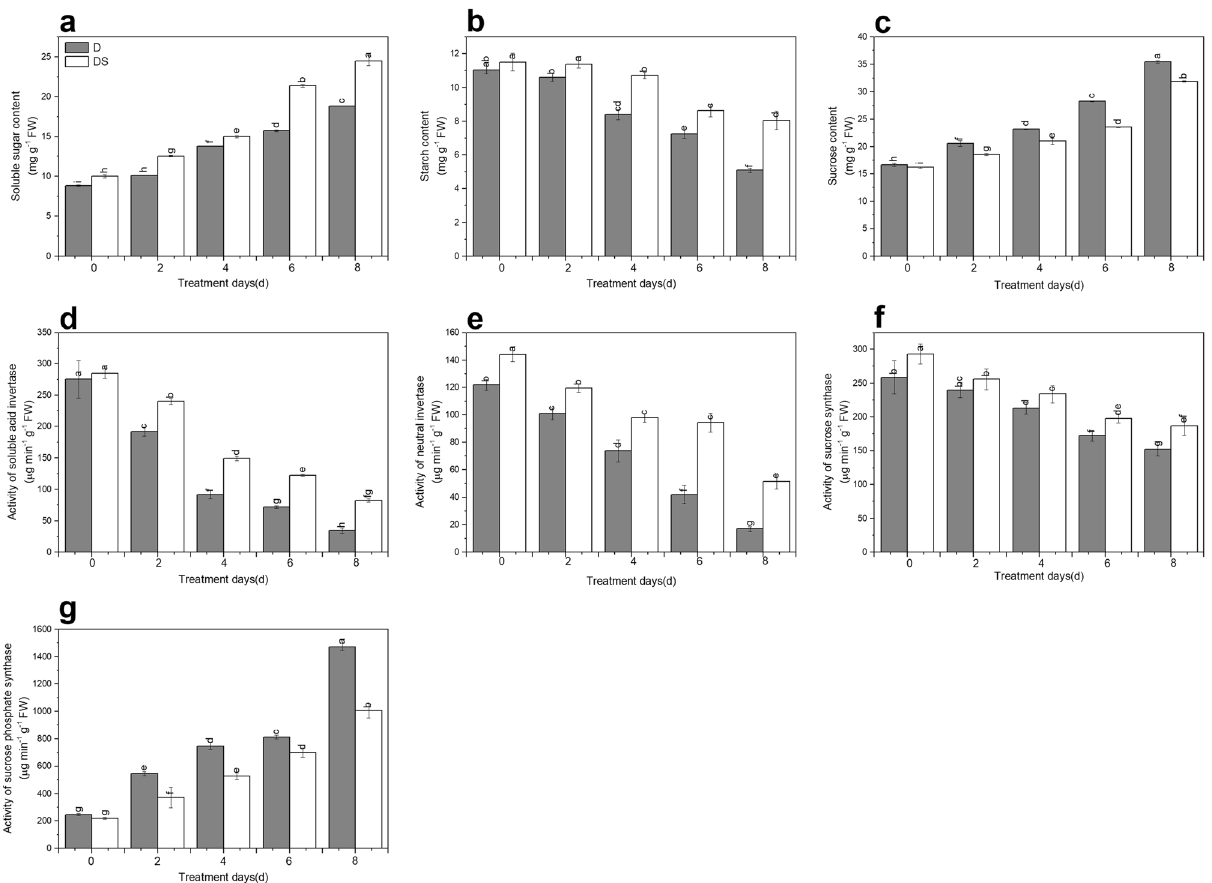
Figure 2. Uniconazole-induced carbon metabolism-related indicators as soluble sugar content ( a ), starch content ( b ), sucrose content ( c ), activity of soluble acid invertase ( d ), activity of neutral invertase ( e ), activity of sucrose synthase ( f ) and activity of sucrose phosphate synthase ( g ) under drought stress. All data are presented as the means ± standard errors (n = 4). D and DS expressed as treatments under drought stress and drought stress + uniconazole,